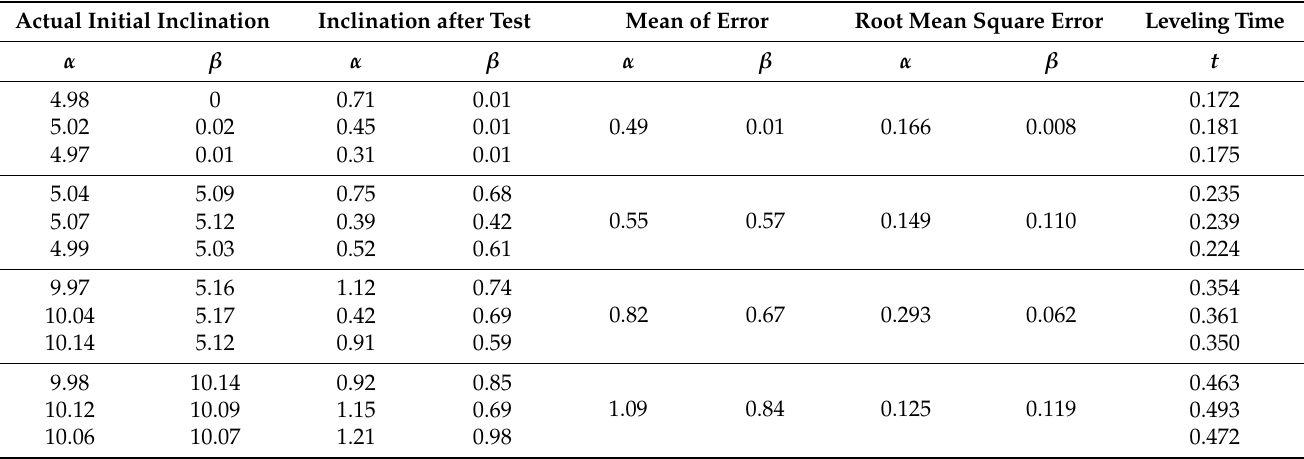
Table 1. Sensitivity test results of lifting